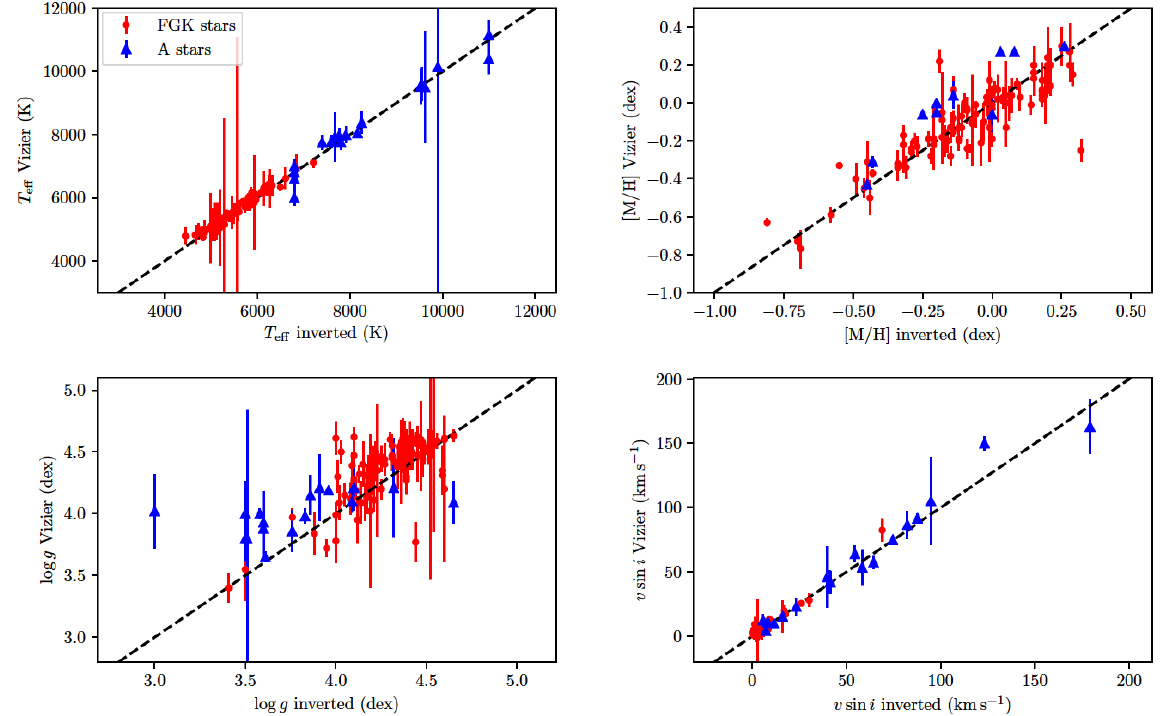
Figure 5. Comparison between the inverted parameters for our FGK stars sample (filled circles) and A stars (filled triangle).